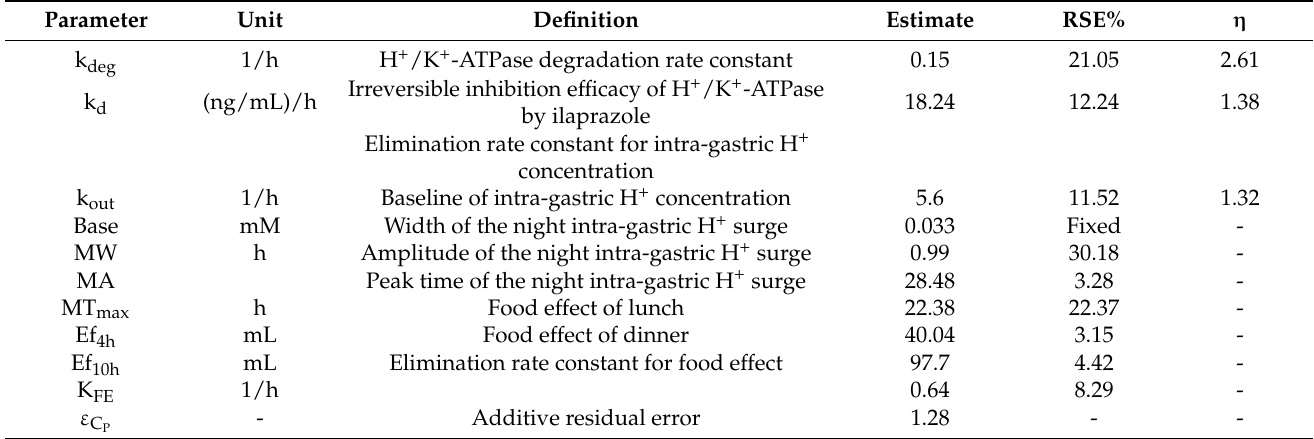
Table 2. The mean ilaprazole pharmacodynamic parameters obtained by nonlinear mixed effects to all doses simultaneously.